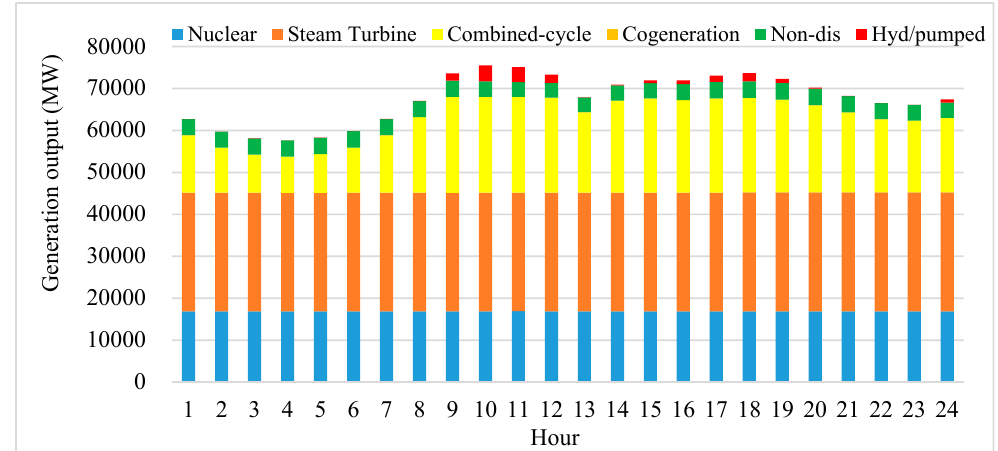
Figure 9. Generation schedule result for S1.